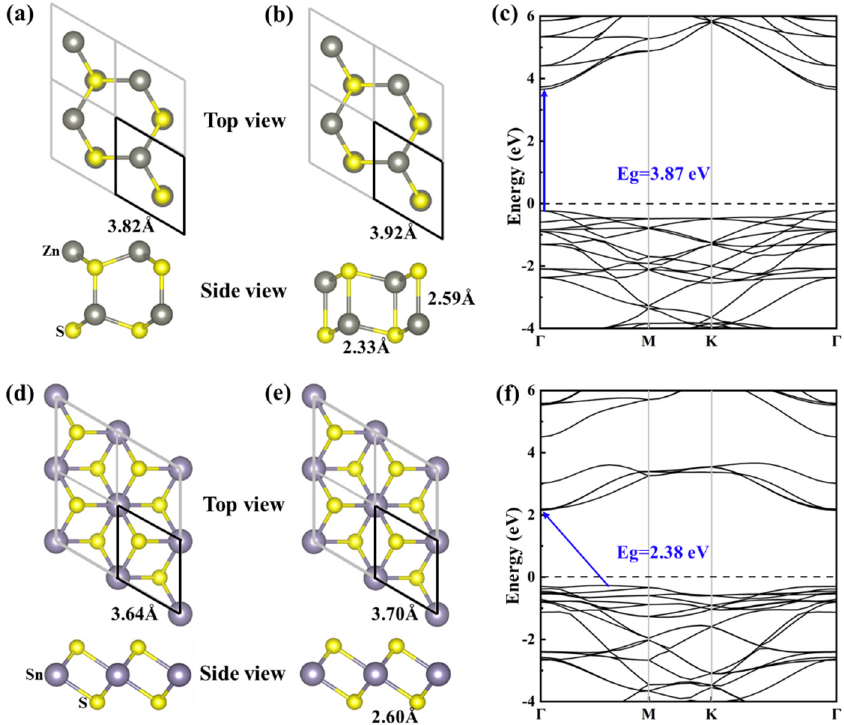
Figure 2. Top and side views of ZnS and SnS 2 monolayer before geometric optimization ( a , d ) and after geometric optimization ( b , e ). The sulfur (S), zinc (Zn), and tin (Sn) atoms are indicated by yellow, gray, and violet balls, respectively. The band structures of monolayer ZnS ( c ) and SnS 2 ( f ). To search for the most stable configuration of the ZnS/SnS 2 heterojunction, six possible stacking models, namely, H1, H2, H3, H4, H5, and H6 are constructed (Figure 3). Among them, H1 and H4 are the original models, H2 and H3 models are obtained by the horizontal movement of the ZnS layer based on the H1 model, and H5 and H6 models are obtained by the horizontal movement of the ZnS layer based on the H4 model. The energy and force convergences of the six configurations were carried out, and the details of the structure and electronic properties of the different configurations are listed in Table 2. Because the heterojunction still maintains the symmetry of lattice and low lattice mismatch rate, no obvious structural change is observed for the ZnS/SnS 2 heterojunction, namely the bond lengths of Zn-S and Sn-S did not change